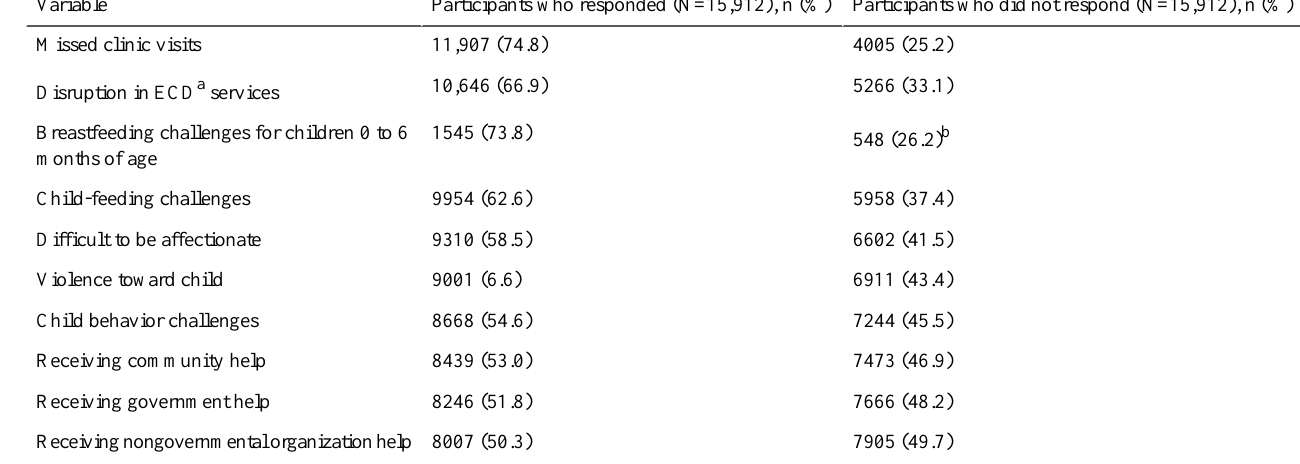
Table 1. Response rates to survey questions and missing values.